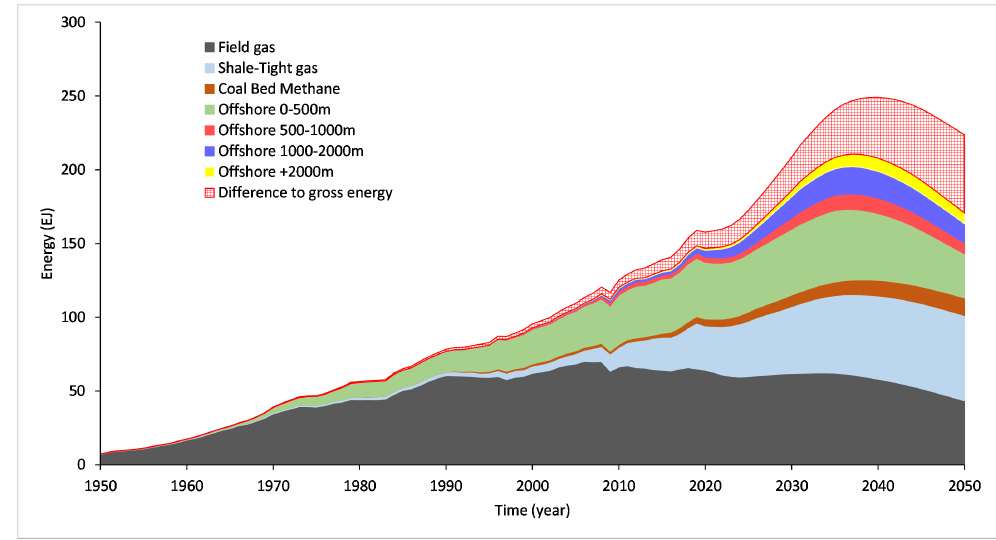
Figure 1. Average gas net-energy production from 1950 to 2050, compared to the gross energy. The weighted-average EROI experiences a steady decrease from its initial value of 141.5 to an apparent plateau of 16.8. This reduction is, in large part, due to the decrease in conventional gases’ EROI, which begins to be inferior to: shale-tight gas EROI in 1992, offshore 500–1000 m in 2000, offshore 1000–2000 m in 2008, offshore +2000 m in 2016 and coal bed methane in 2022. Let us note that the drop-off of the conventional gases towards 2012 is linked to the reconciliation of the yearly EROI calculation with the historical and prospective exploitation resource ratios, a parameter used in the functional form definition (we recommend the reader consults the work of Court and Fizaine to clarify the theorized functional forms of EROI). Figure 2 illustrates the evolution of the EROI of all gas types, and the weighted average from 1950 to